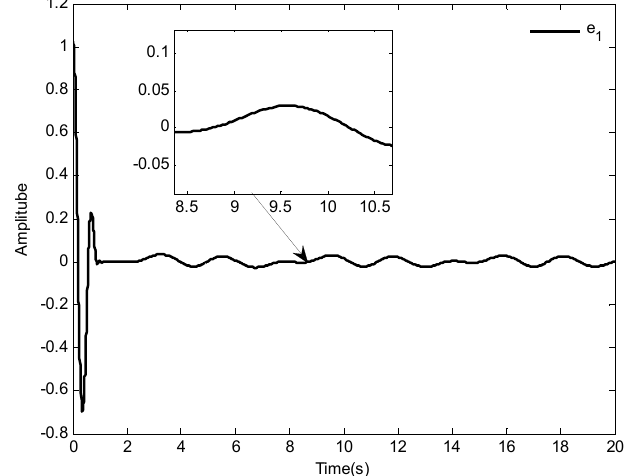
Figure 3. The curve of tracking error.